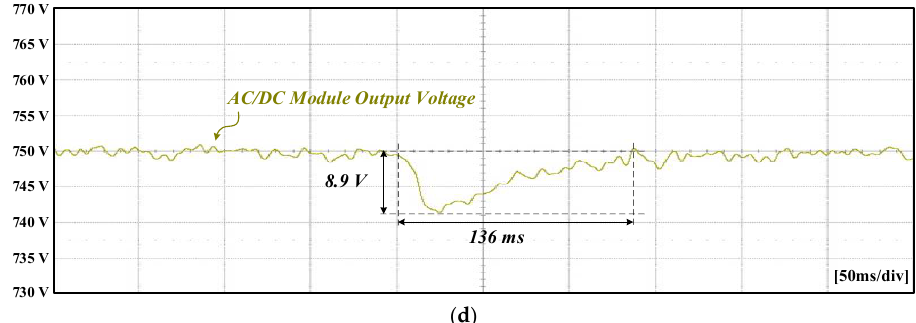
Figure 13. Experimental waveforms without the proposed method. ( a ) Reference and real voltage; ( b ) reference and real voltage of DC Bus (expanded); ( c ) reference and real q -axis current in synchronous frame; and ( d ) output voltage of module 1 (expanded).